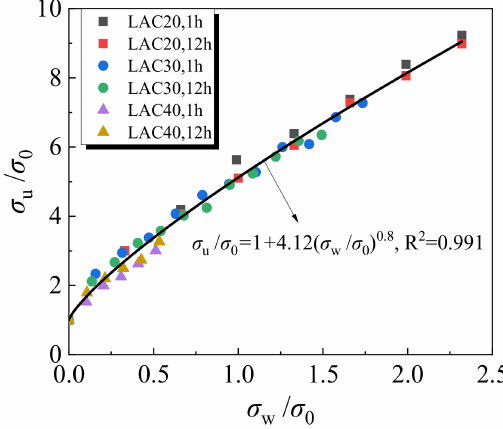
Figure 8. Relationship between compressive strength and lateral confining pressure.